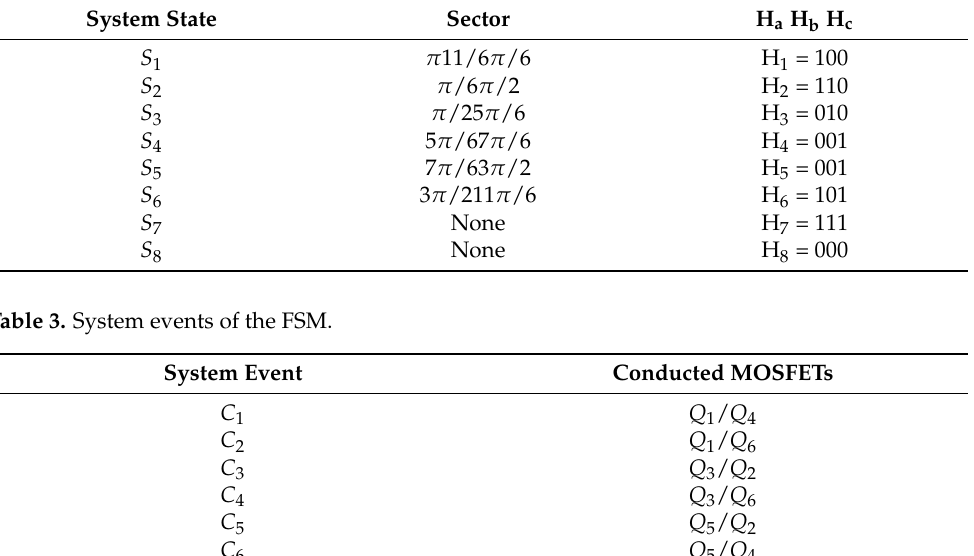
Table 2. System states of the FSM.